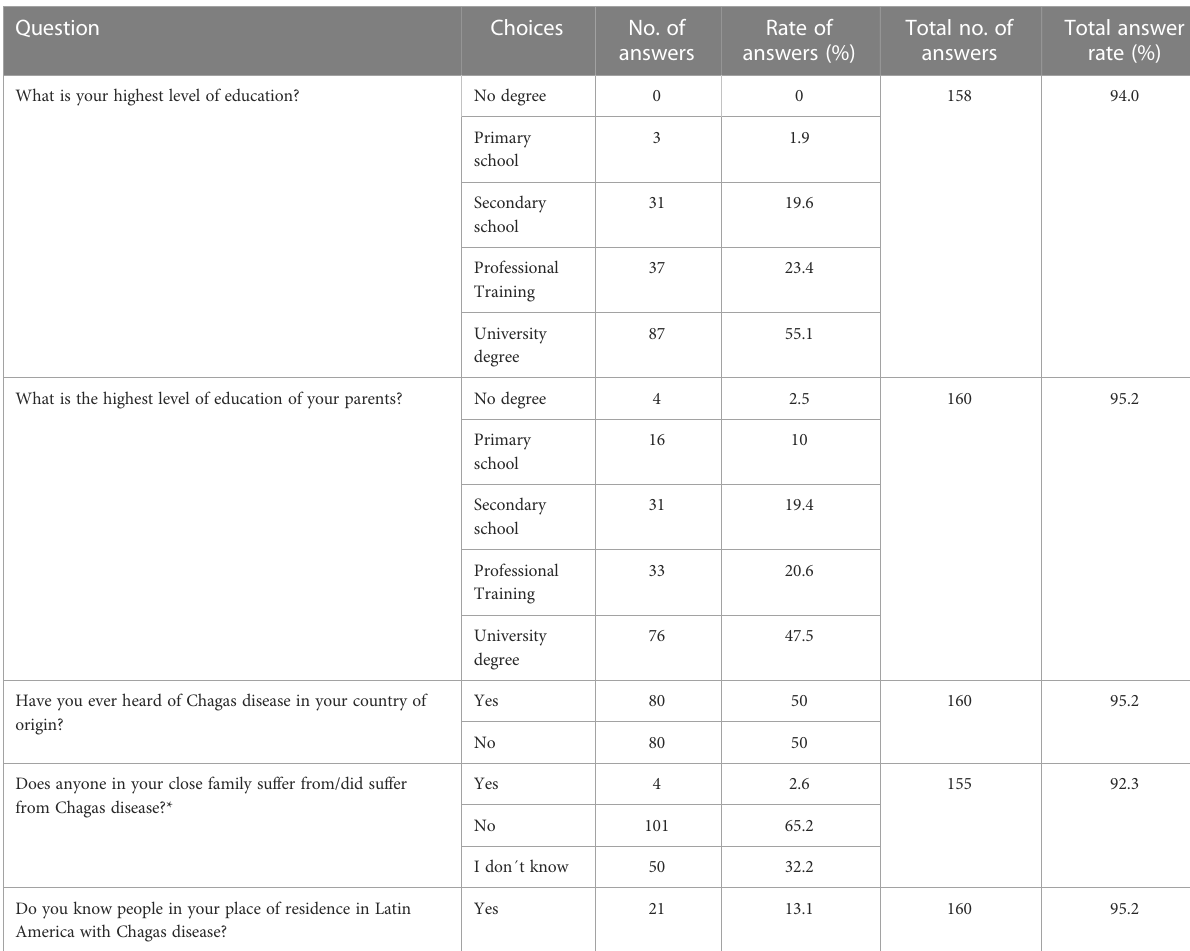
TABLE 2 Socioeconomic risk factors for infection with T. cruzi